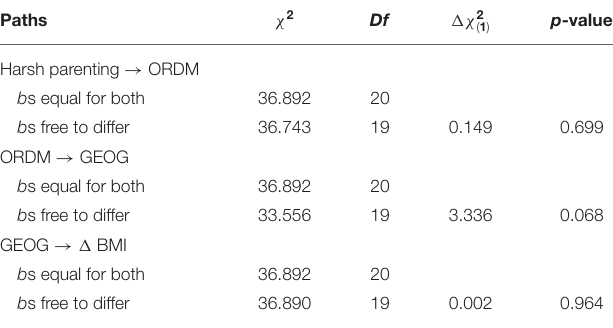
TABLE 4 | Multiple group comparison between females and males.